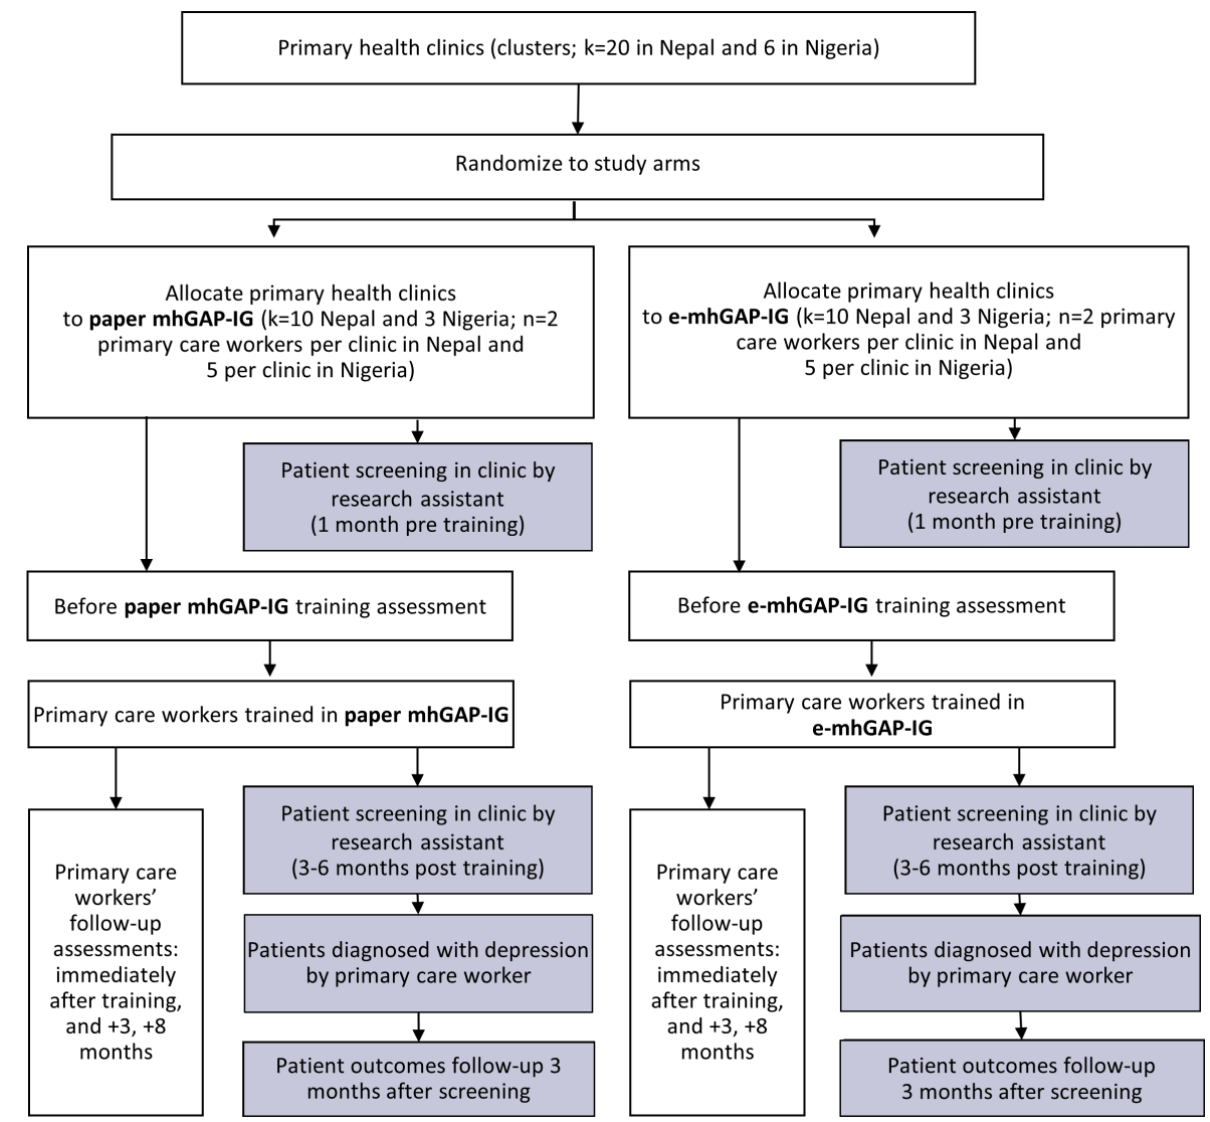
Figure 2. Emilia (E-mhGAP Intervention Guide in Low- and Middle-Income Countries: Proof-of-Concept for Impact and Acceptability) flow chart. e-mhGAP-IG: electronic Mental Health Gap Action Programme Intervention Guide; mhGAP-IG: Mental Health Gap Action Programme Intervention